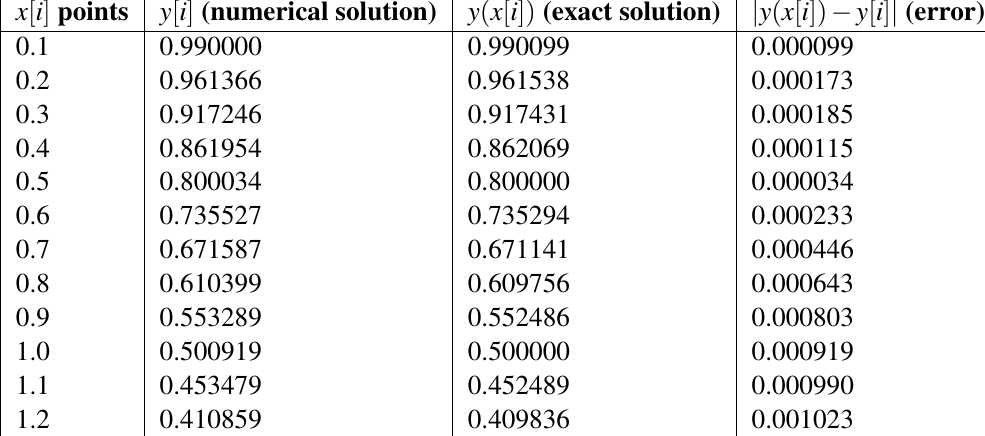
Table 4 Improved B-theoretical algorithm